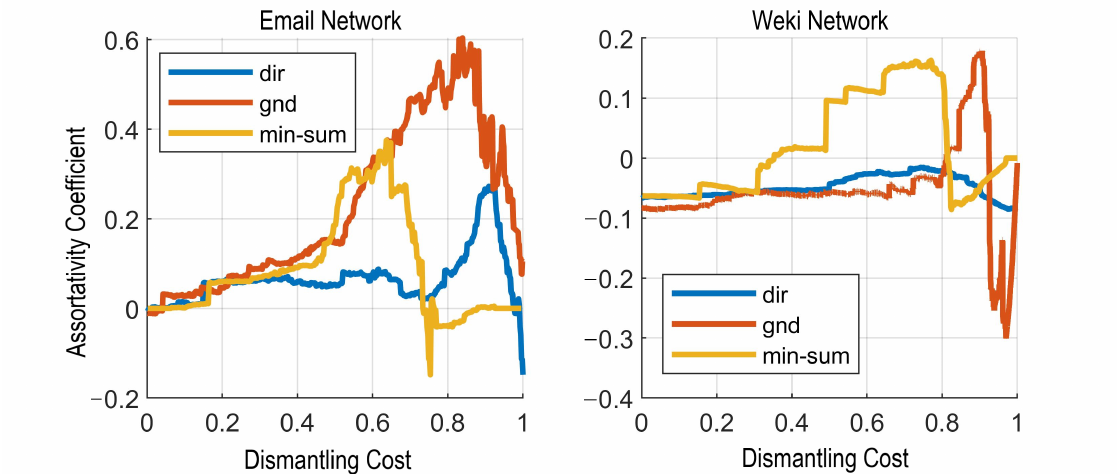
Figure 7. Curve graph of real network disassembly cost and assortativity